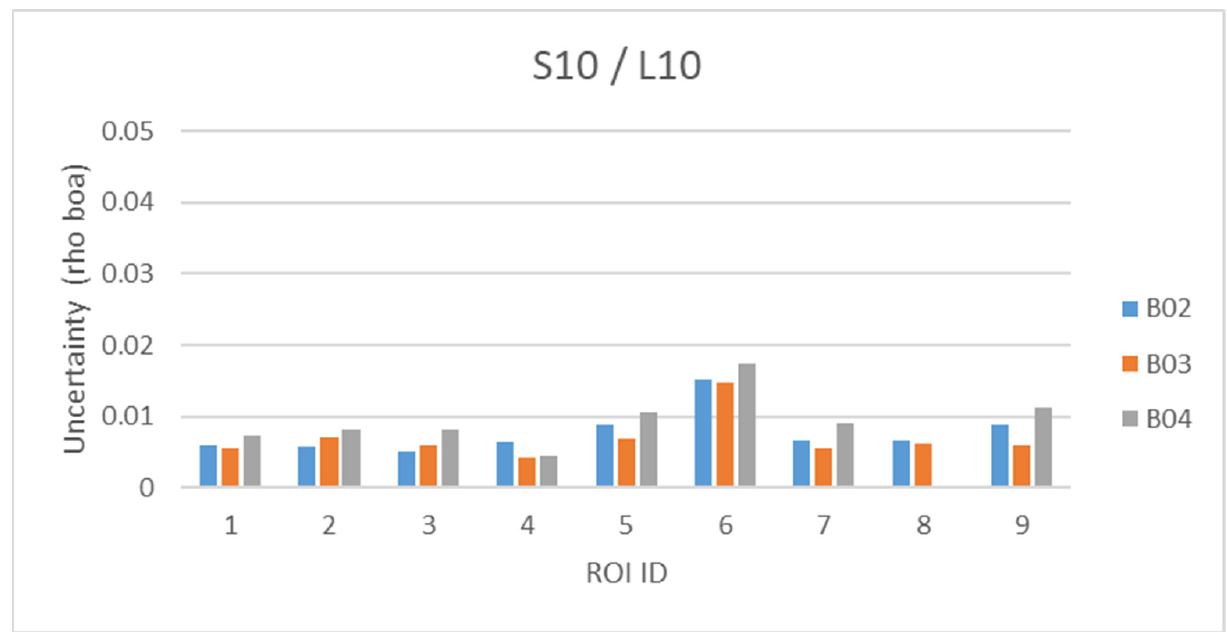
Figure 13. LS8/S2 L2F uncertainties for the nine ROIs. The original LS8 images and the S2-like LS8 30 m images (L2F images) are shown in Figure 14 for visual comparison. The qualitative assessment shows that the S2L